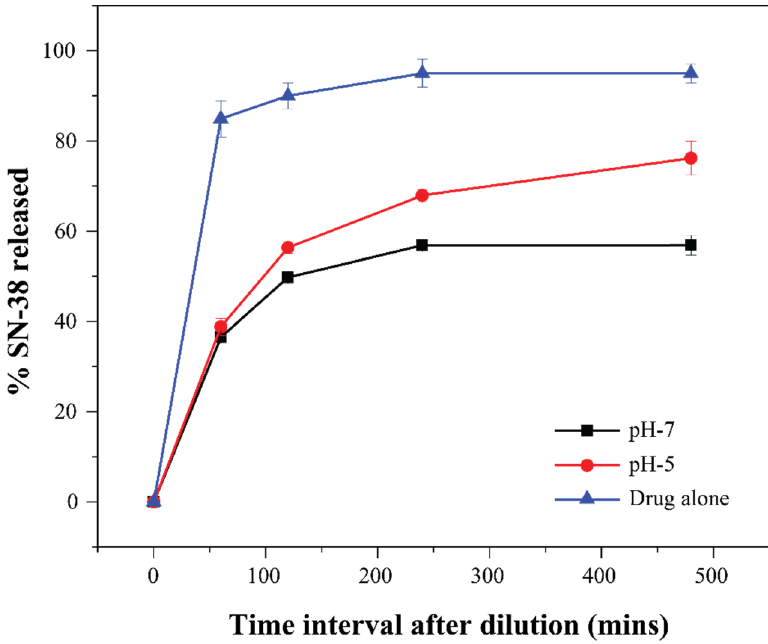
Figure 7. Release profile of SN-38 from the LNPs prepared using MO and OAPy-4. The LNPs were placed in a dialysis tube suspended in 1000 mL of release medium of PBS buffer at pH 7.0 and pH 5.0. SN-38-loaded nanoparticles were hexosomes at neutral pH and cubosomes at pH 5. Experiments were performed in triplicate on three separately prepared SN-38-loaded LNP formulations. All values are expressed as the mean ± SD (n = 3).